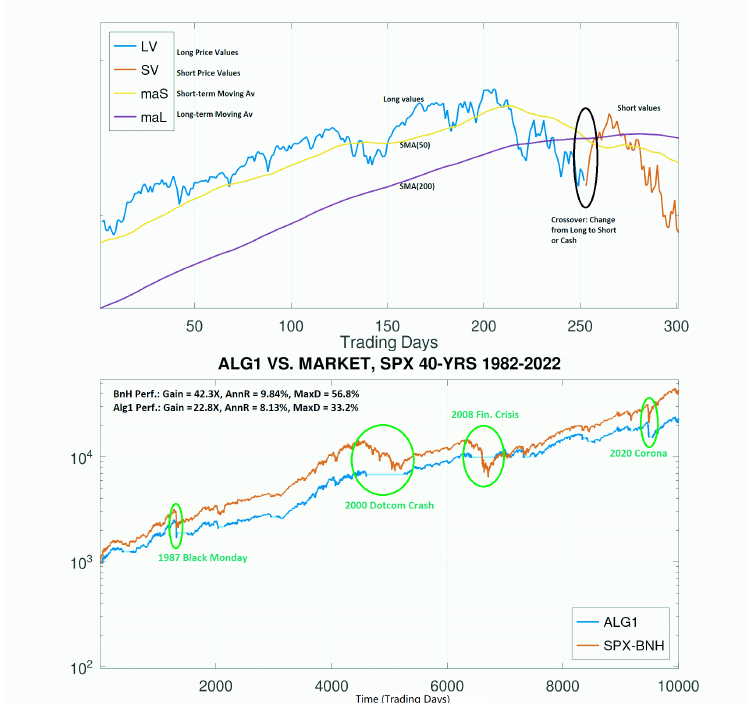
Figure 8. ( top ) Example of Algorithm 1 in action, with a segment of the S&P500 data, showing key elements. When SMA(50) crosses below the SMA(200), the method switches from long to short or cash, and vice versa. ( bottom ) Performance of Alg1 vs. BnH, on SPX, 1982–2022. Alg1 underperforms simple BnH, but it reduces drawdowns. That in itself may be a benefit for small